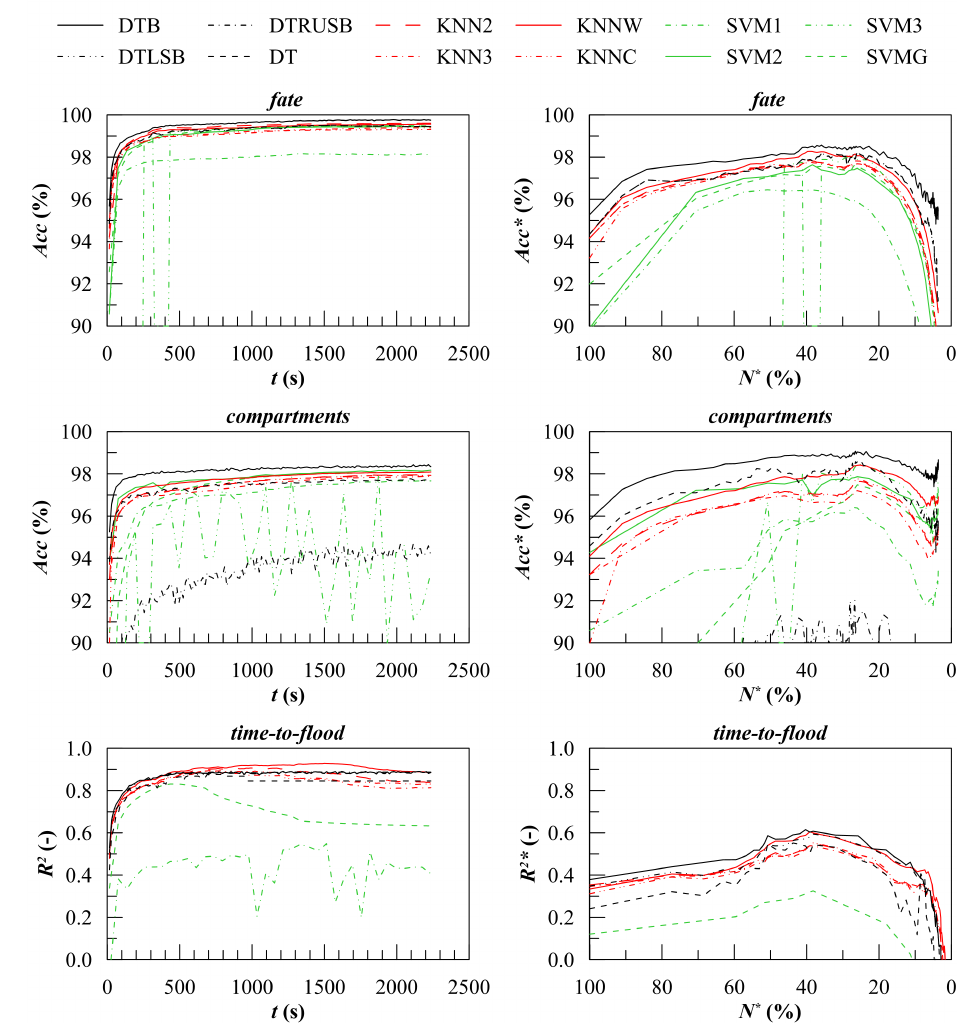
Figure 10. Comparison of accuracy of different classification methods. Training: MC20; validation: